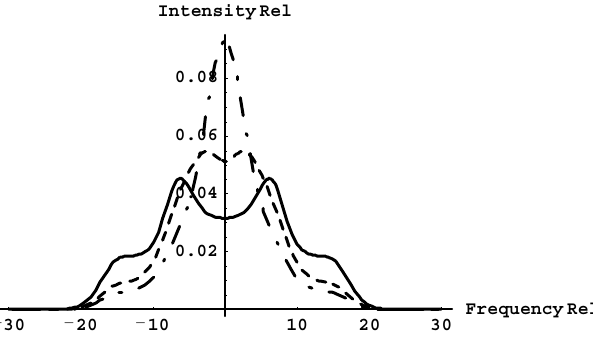
Figure 7. Dependence of the Ly-beta profiles for the case of the Langmuir solitons on the scaled distance b = L/ λ between the Langmuir solitons in the sequence for b = 2 (solid line), b = 4 (dashed line), and b = 6 (dash-dotted line).